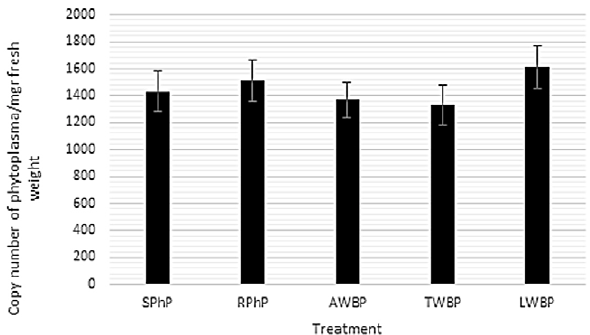
Figure 5. Mean concentrations of lime witches’ broom